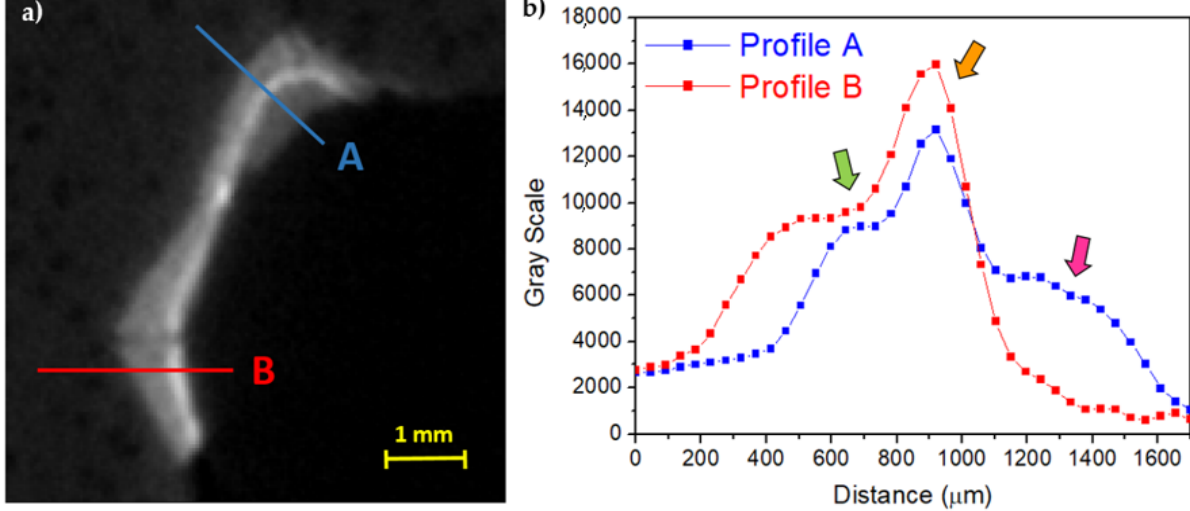
Figure 6. ( a ) Enlargement of Figure 5c and ( b ) the profile plots along A and B (green arrow: preparation layer; orange arrow: preparation material for the gold leaf adhesion; pink arrow: material layer above the gold leaf).